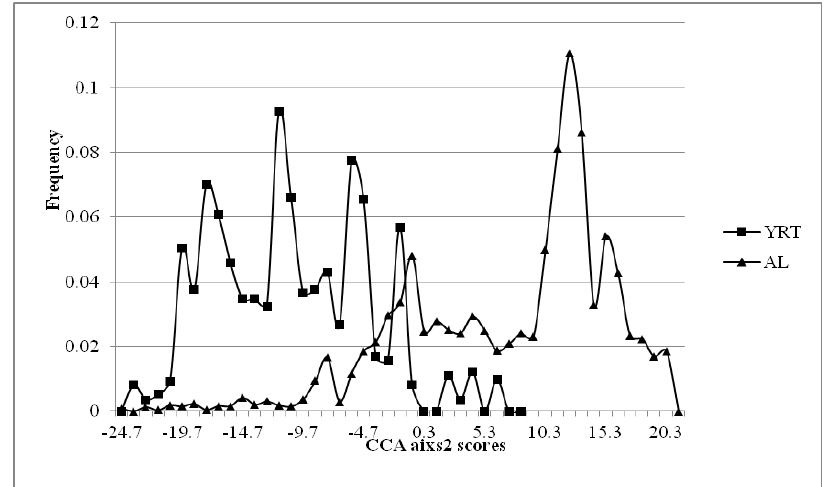
Figure 13. Frequency distribution of CCA scores for YRT and AL in